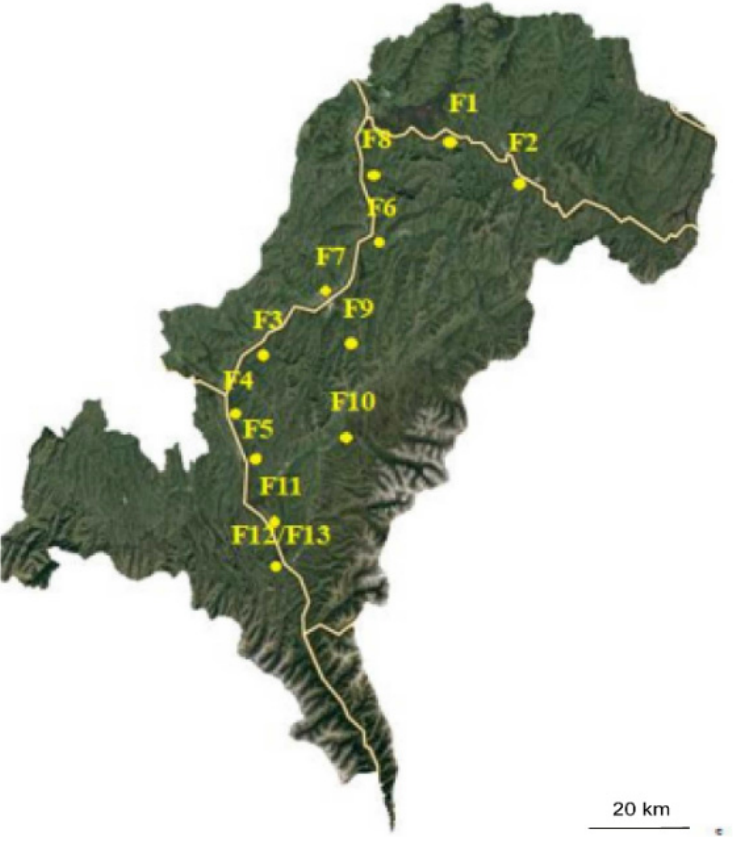
Figure 1. Approximate location of the isolates in the Aba Tibetan Autonomous Prefecture, China. The yellow line represents the river. F1–F13 are abbreviations for Farms 1–13. The latitude and longitude of farms 12 and 13 were the same.